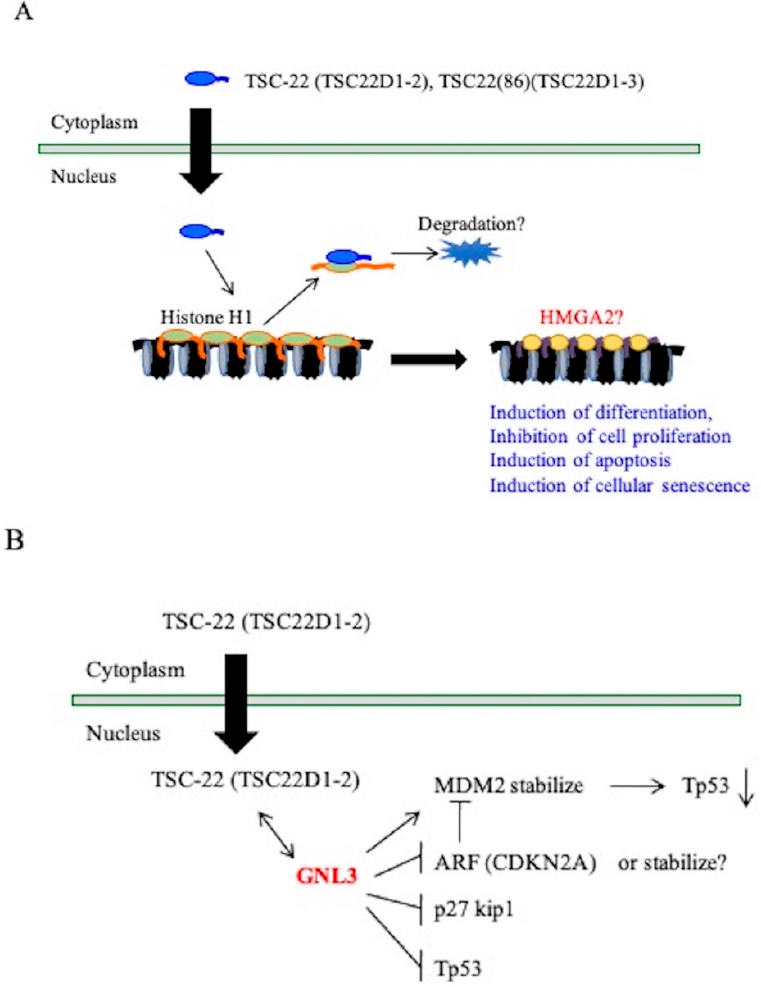
Figure 8. Putative function of TSC-22 (TSC22D1-2) and TSC-22(86) (TSC22D1-3). ( A ): TSC-22 may promote the degradation of histone H1 through this interaction, and replacement of chromatin binding by HMGA2 may cause changes in the expression of genes that regulate cell proliferation and differentiation, apoptosis induction, and cell senescence. ( B ): GNL3 is known as nucleostemin and is found in the nucleolus. GNL3 interacts with p53 and MDM2. TSC-22 (TSC22D1-2) might influence the inhibitory action of GNL3 on tumor cell growth.